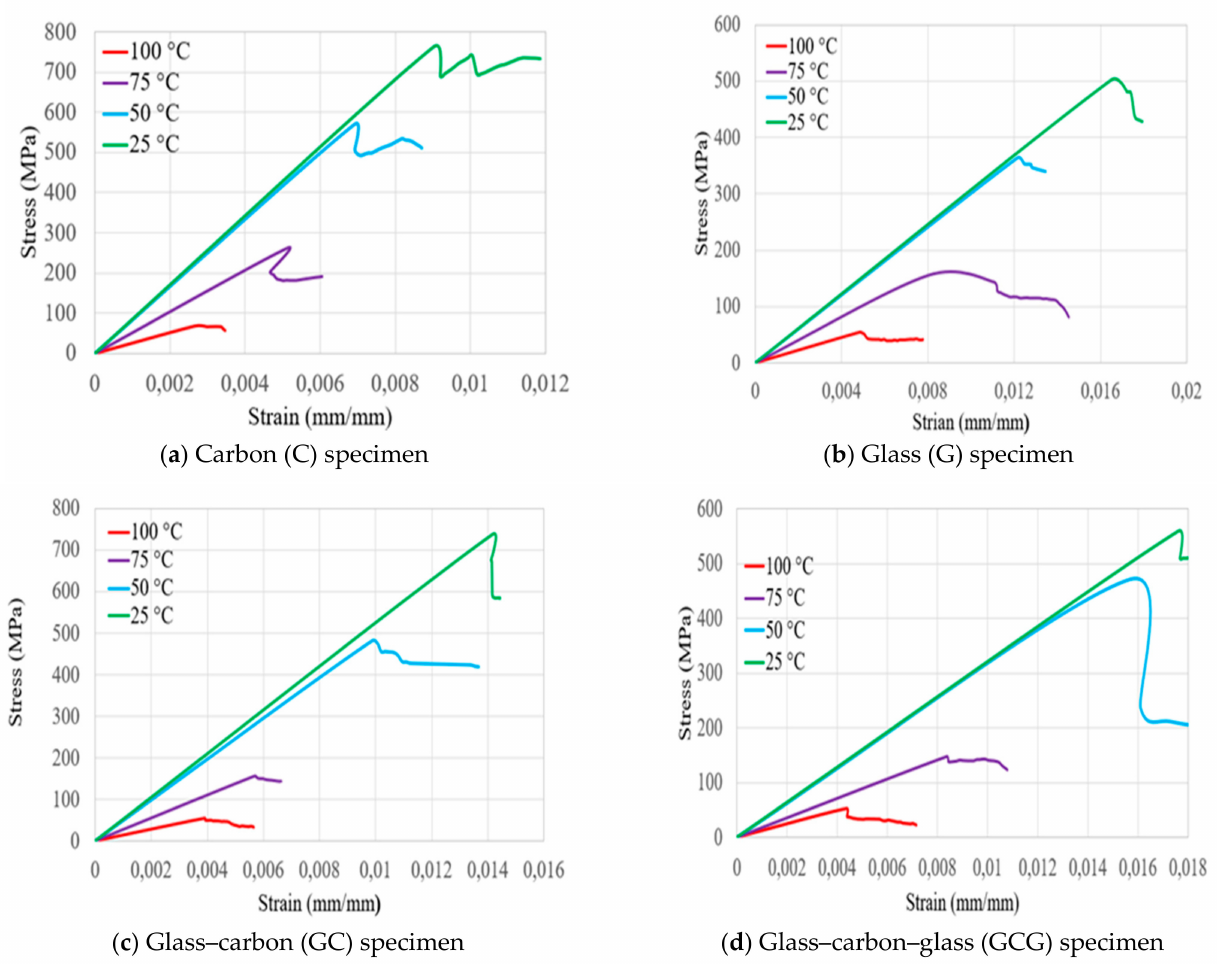
Figure 3. Stress–strain curves of the tested hybrid and non-hybrid composite specimens.